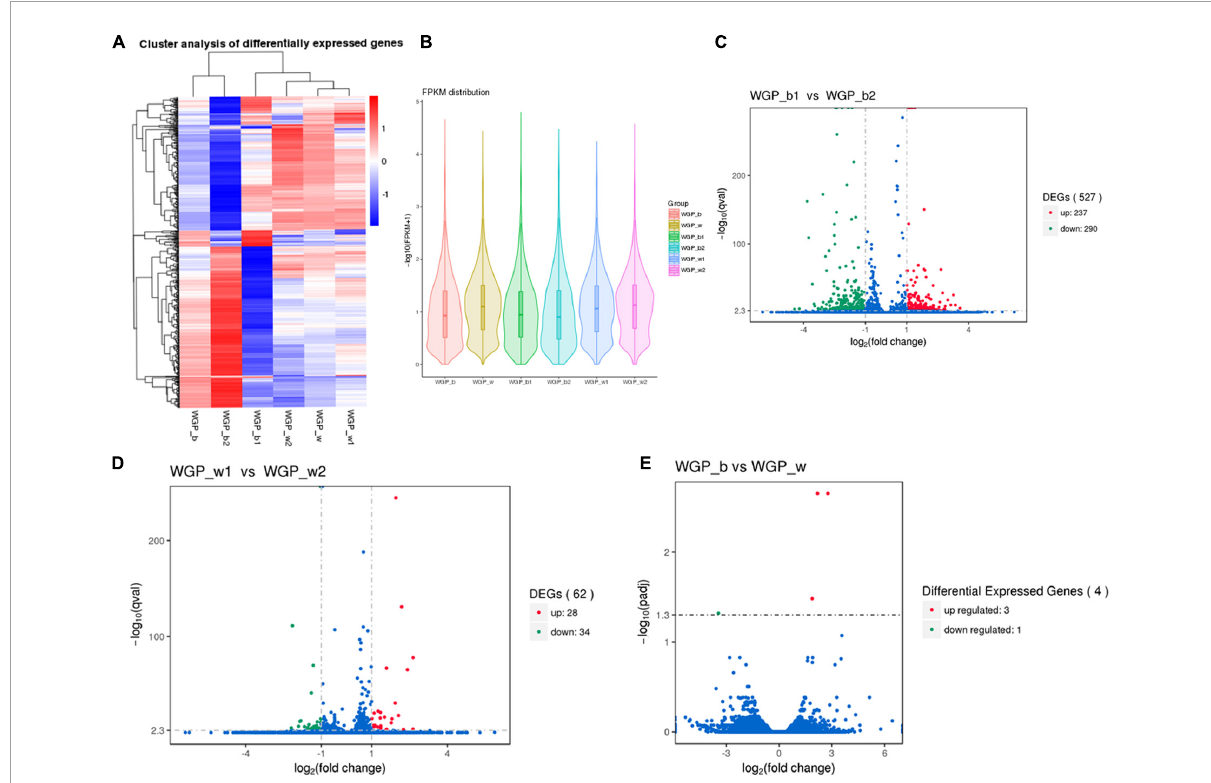
FIGURE2 Comparison of gene expression levels. (A) The overall FPKM hierarchical clustering diagram, the log10 (FPKM + 1) values were scaled number and clustered. Red represents highly expressed genes and blue represents low expressed genes. The color ranges from red to blue, indicating log10 (FPKM + 1) from large to small. (B) FPKM violin plot with sample name on the X -axis and log10 (FPKM + 1) on the Y -axis. Each region’s Violin plot corresponds to five statistics (maximum, upper quartile, median, lower quartile and minimum, respectively, from top to bottom). The width of each violin represents how many genes were under that expression. (C–E) Volcano plot of the overall distribution of differential genes. Genes with significant differentially expressed genes are represented by red dots (up-regulated) and green dots (down-regulated), while genes without significant differentially expressed genes are represented by blue dots. The abscissa represents the fold change of gene expression in different samples. The ordinate represents the statistical significance of the difference in gene expression.